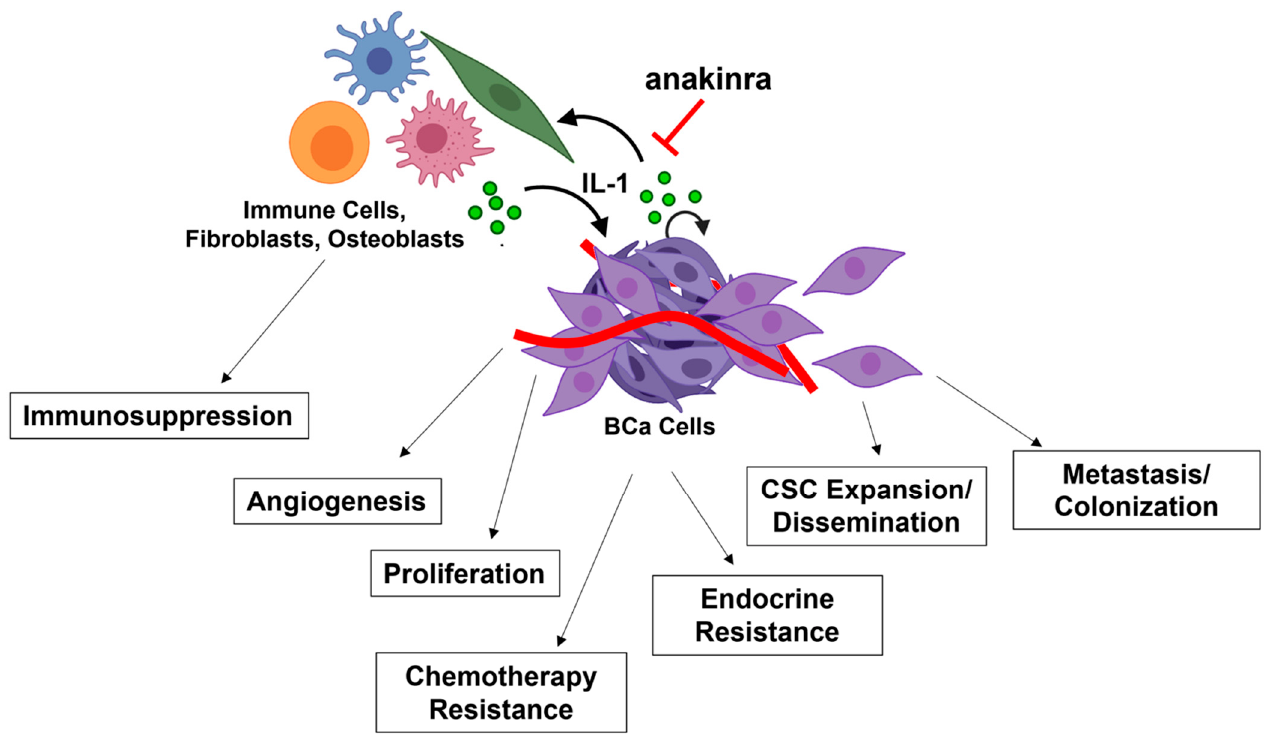
Figure 2. IL-1 promotes BCa tumor progression and treatment resistance. IL-1 is secreted by cells of the primary and metastatic tumor microenvironment, such as tumor cells, immune cells, fibroblasts, and osteoblasts to activate canonical, intracellular NF- κ B signaling. IL-1 autocrine and paracrine signaling induce breast cancer (BCa) cell proliferation, tumor angiogenesis, cancer stem cell (CSC) expansion and dissemination, tumor cell metastasis, and tumor cell colonization of the metastatic niche. In addition to promoting tumorigenic phenotypes, IL-1 supports BCa therapeutic resistance, including endocrine resistance, chemotherapeutic resistance, and resistance to immunotherapy. The IL-1 inhibitor, anakinra, can reverse IL-1-induced BCa tumorigenicity and therapeutic resistance. Image created using BioRender.